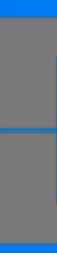
Figure 5. Axisymmetric representation (cylindrical coordinates) of AWG24 round conductors in an RM6 core with an air gap.